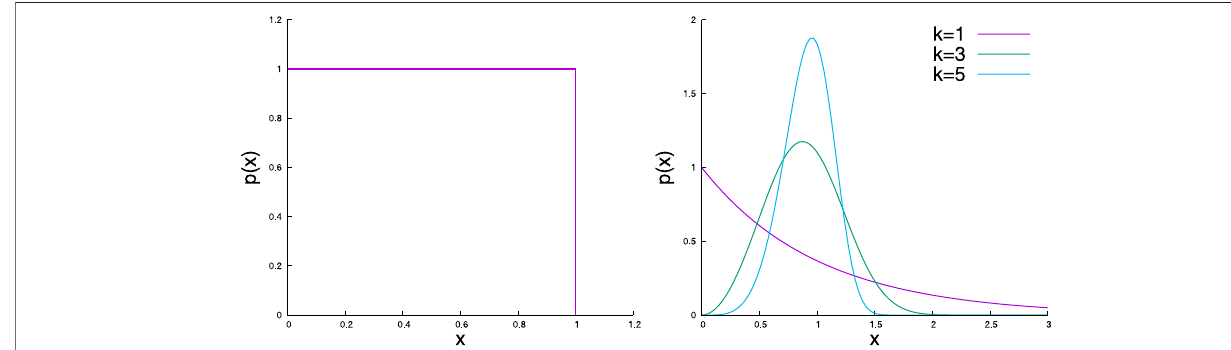
FIGURE 2 | The uniform and Weibull distributions of fi ber strengths